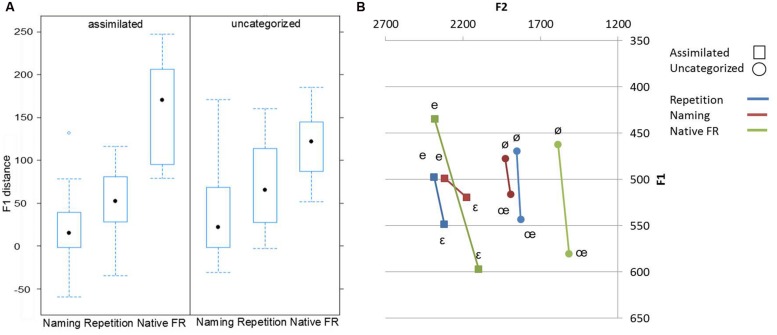
F1-distances between the contrastive vowels produced by Spanish speakers in the naming and repetition tasks and by native French speakers. (A) Median, lower and upper quartiles and the minimum and maximum F1-distances as function of task and contrast. (B) Mean F1-distances for assimilated and uncategorized contrasts as function of task.